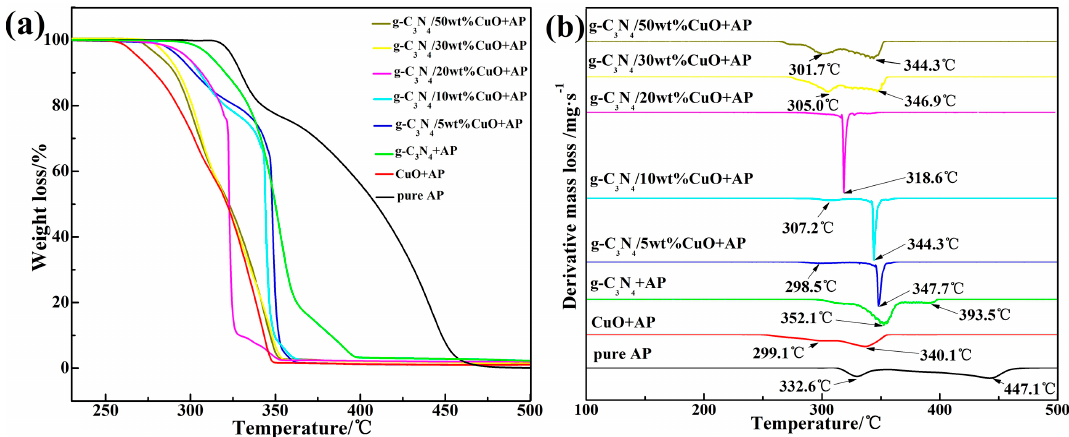
Figure 6. Thermal gravimetric analysis (TGA) ( a ) and derivative thermogravimetric analysis (DTG) ( b ) curves of ammonium perchlorate (AP) in the absence and presence of catalysts. Table 1. High decomposition temperature and high weight-loss decomposition temperature of ammonium perchlorate (AP) in the absence and presence of different catalyst. High Sample